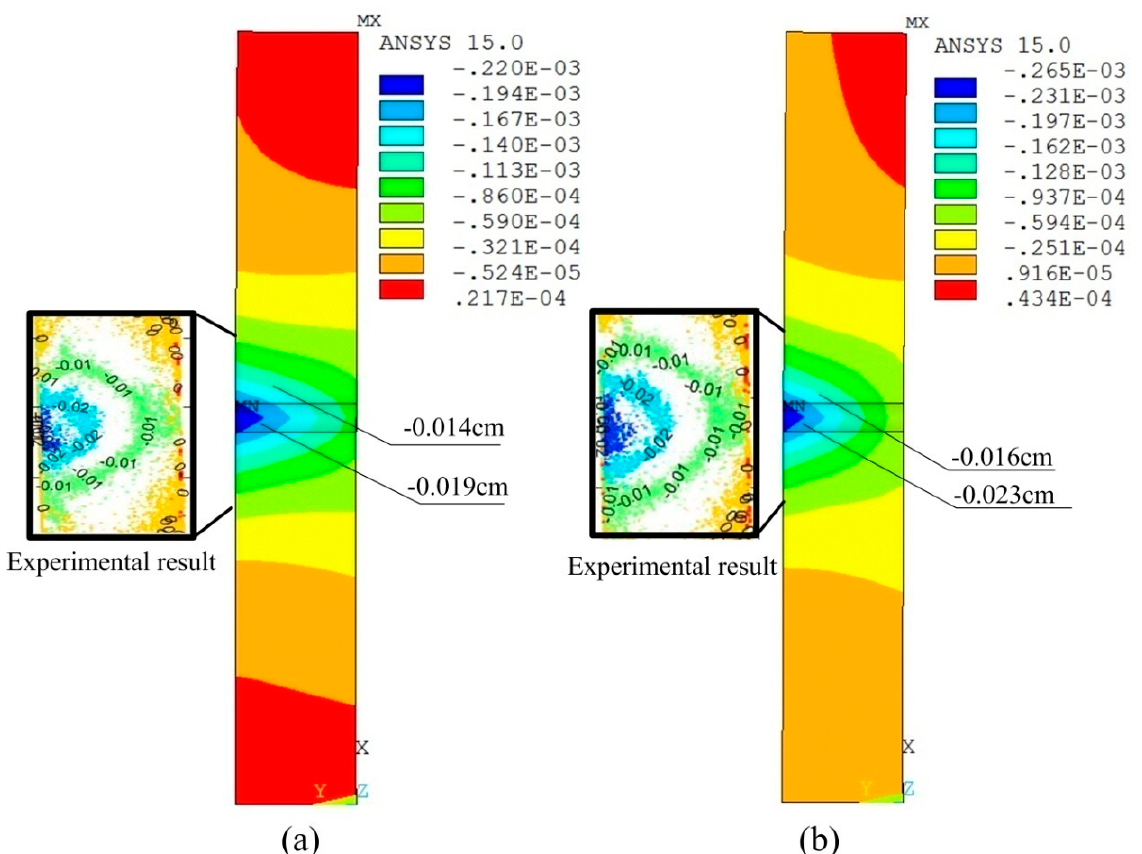
Figure 18. Additional bending moment in an extreme case.